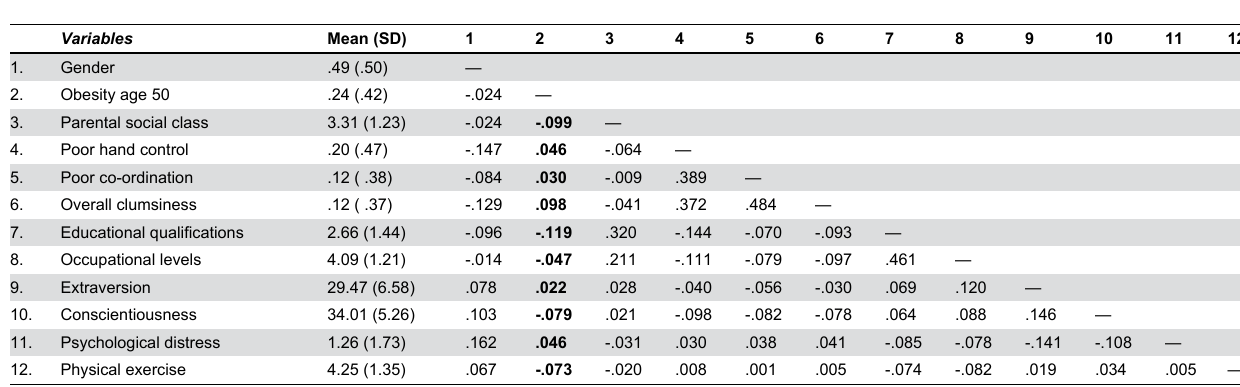
Table 2. Pearson product-moment correlations of gender, adult obesity, parental social class, childhood neurological function, educational qualifications, occupational levels, personality traits, psychological distress, and physical exercise.